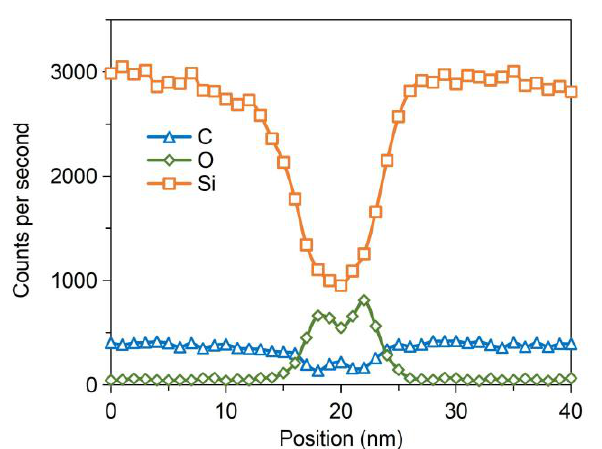
Figure 7. Energy-dispersive X-ray spectroscopy (EDX) line scanning analysis of the SiC–SiC bond- ing